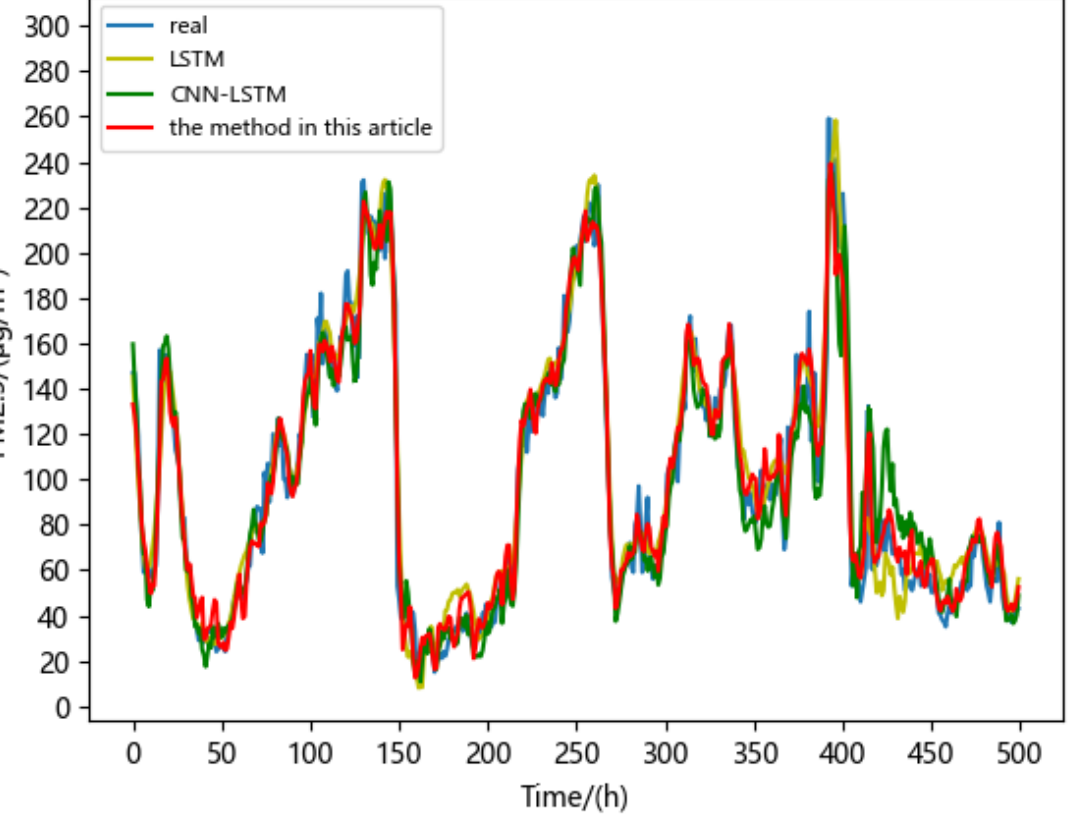
Figure 6. The prediction results of the three methods with a prediction step of 4 h.